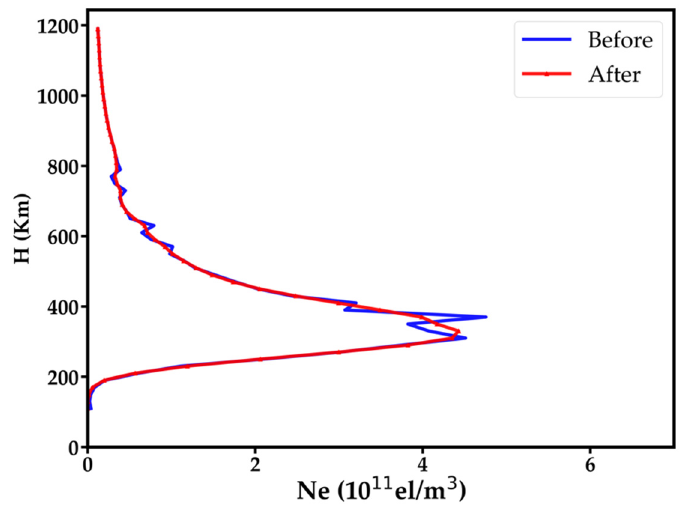
Figure 2. Comparison of the vertical profiles before and after the usage of the piecewise fitting and per-voxel averaging